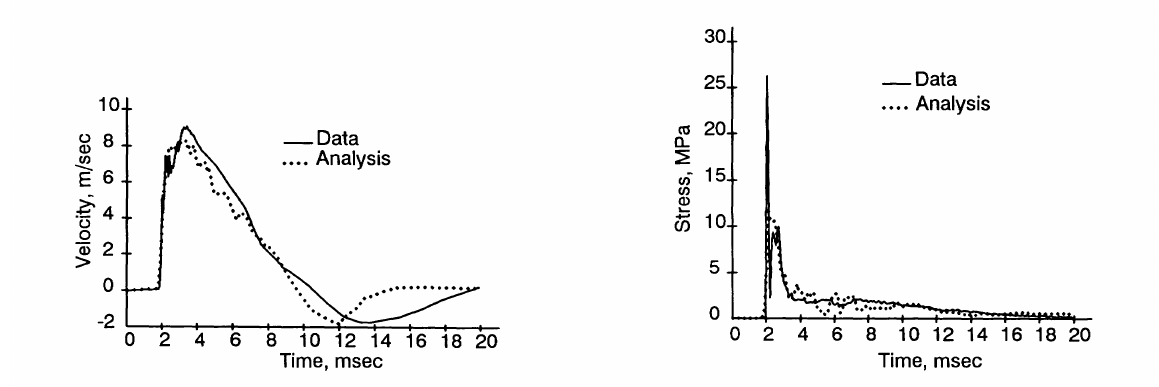
FIGURE 15 Deformational velocity, test 2.